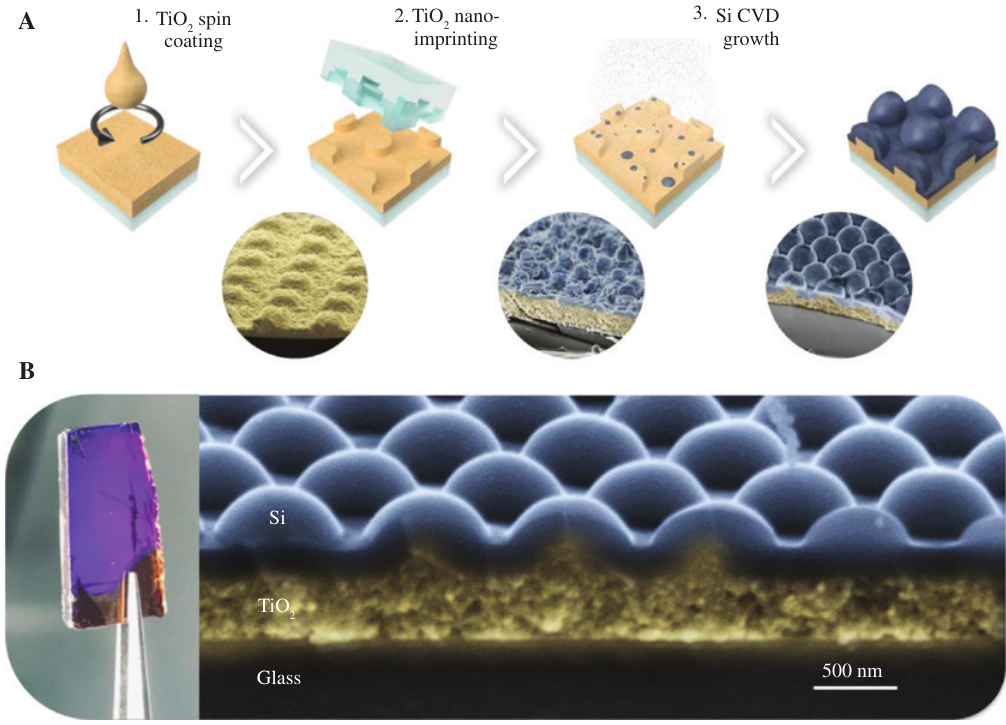
Figure 1: Si metasurface fabrication. (A) Schematics of the different steps involved, namely: (1) spin casting the titania paste, (2) nanoimprinting and annealing step and (3) silicon coating by chemical vapor deposition (CVD). (B) Scanning electron microscopy (SEM) cross section and photograph of a fabricated